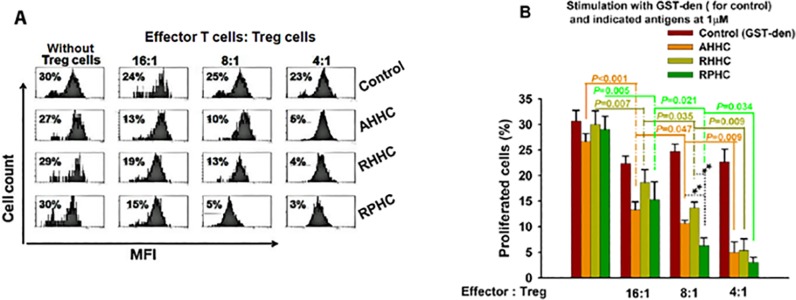
Investigation of antigen-specific regulatory function in antigen-immunized mice.Inhibition of CD4+CD25- effector T cell proliferation by CD4+CD25+ regulatory T-cells isolated from the spleen of control (GST-Den–immunized) and construct-immunized mice when AHHC, RHHC and RPHC were used as antigens. (A) Quantitative analyses of proliferation of CD4+CD25- effector T cells in the presence of Treg cell by flow cytometry is shown. (B) Proliferation of effector cells isolated from immunized mice alone is indicated in the leftmost bar of each group. Addition of Treg cells to T effector cells at different ratios was also shown. Data are given as mean of 3 analyses ± SEM.